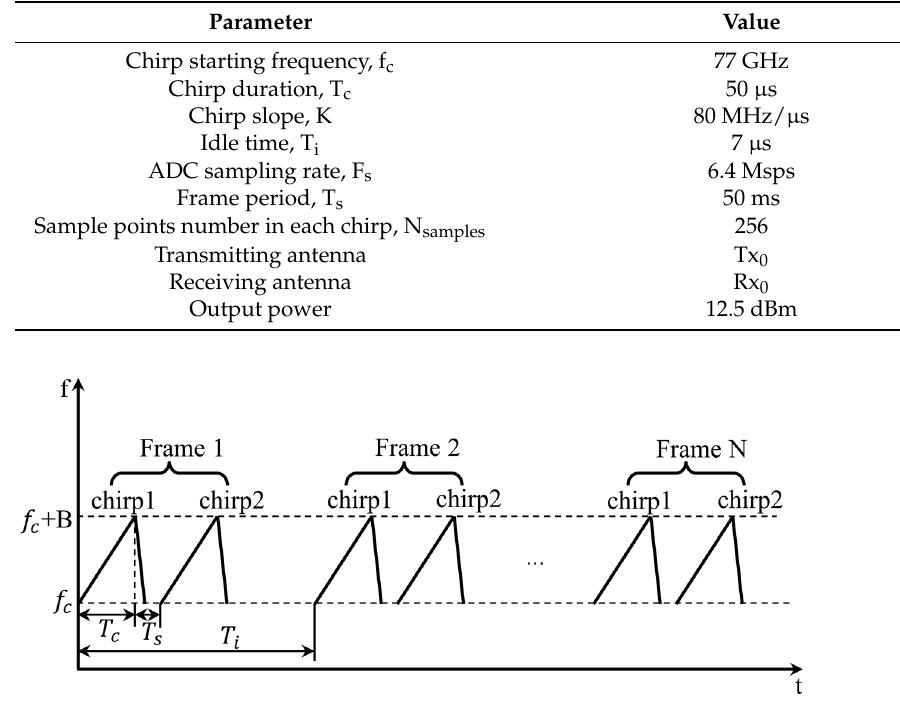
Figure 9. The parameter settings of the sensor.